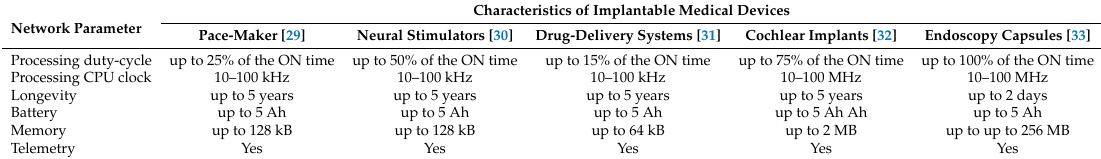
Table 1. Technical specifications of implantable medical